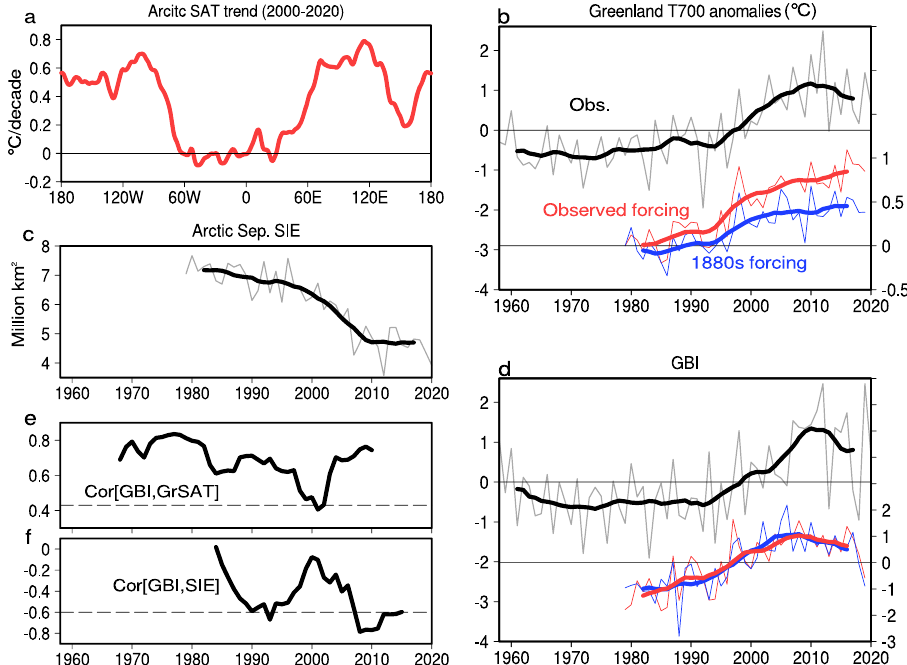
Fig. 1 Recent slow-down in summer warming over Greenland. a Longitudinal section of the linear trend of summertime surface air temperature (SAT) averaged over the Arctic (poleward of 60°N) for 2000 – 2020. Greenland is roughly located at 20° – 60°W. b Time series of 700-hPa temperature anomaly over Greenland (60° – 85°N, 20° – 60°W) in JRA55 reanalysis (grey line) for 1958 – 2020 (anomaly is relative to a climatological mean) and in ECHAM simulations forced by observed (red line) and 1880s (blue line) radiative forcings for 1979 – 2020 (anomaly is relative to 1979). ( c ) Time series of Arctic sea ice extent (Million km 2 ) in September. d As in ( b ), but for the Greenland Blocking Index (GBI). Thick lines in ( b , c , and d ) denote a smoothed seven-year running mean. ( e ) 21-year running correlation between GBI and Greenland SAT. ( f ) 11-year running correlation between GBI and September Arctic sea-ice extent (SIE). Dashed line denotes the 95% signi fi cant level. The correlation is plotted at year 11 (6) of the 21 (11)-year